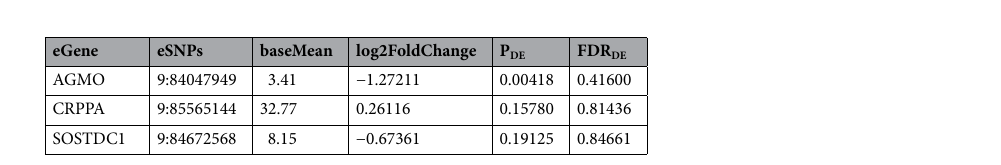
Table 2. eGenes among Differentially Expressed RFI QTL